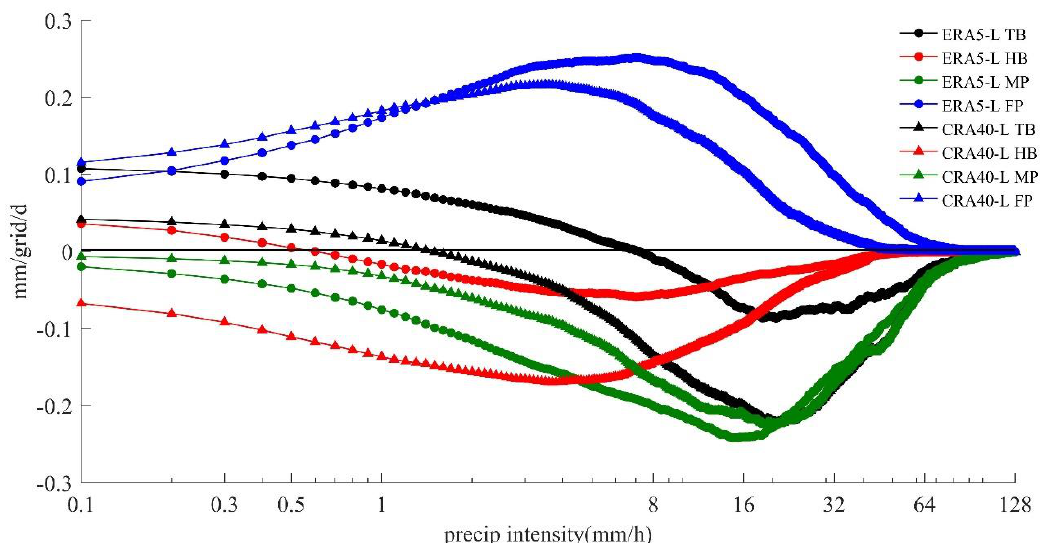
Figure 11. Correlation between precipitation intensity and error components TB , HB , MP , and FP (logarithmic base 10 on the abscissa).